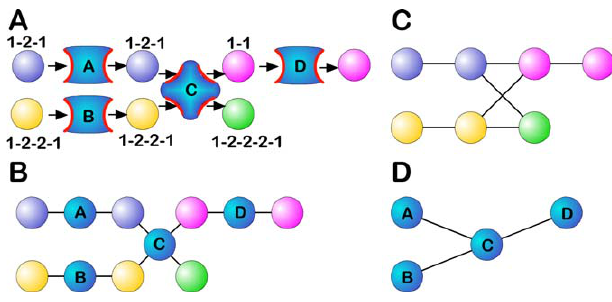
Figure 1. Representations of a Metabolic Pathway Pathway importing precursors 1-2-1 and 1-2-2-1 using transport proteins A and B, respectively, producing molecules 1-1 and 1-2-2-2-1 via enzymatic protein C, and exporting the by-product 1–1 using protein D. (A) Pathway, (B) functional graph, (C) metabolic graph, and (D) protein– protein interaction graph.